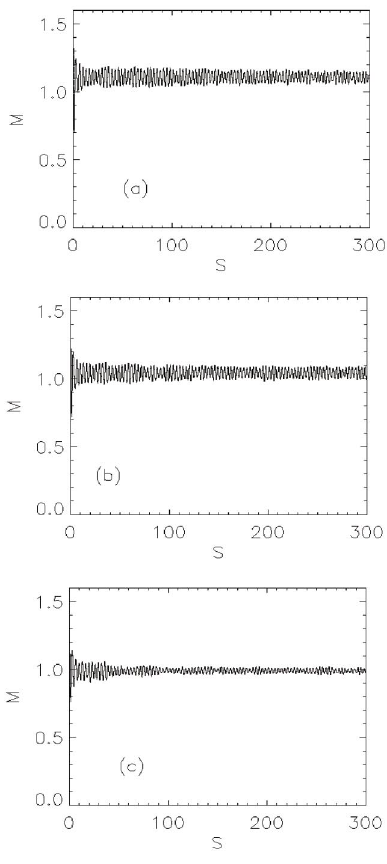
FIG. 6. Oscillation of the rms width of the beam with nonlinear focusing for (cid:4) (cid:1) (cid:4) a (cid:5) 1.5, (b) 1.35, (c)